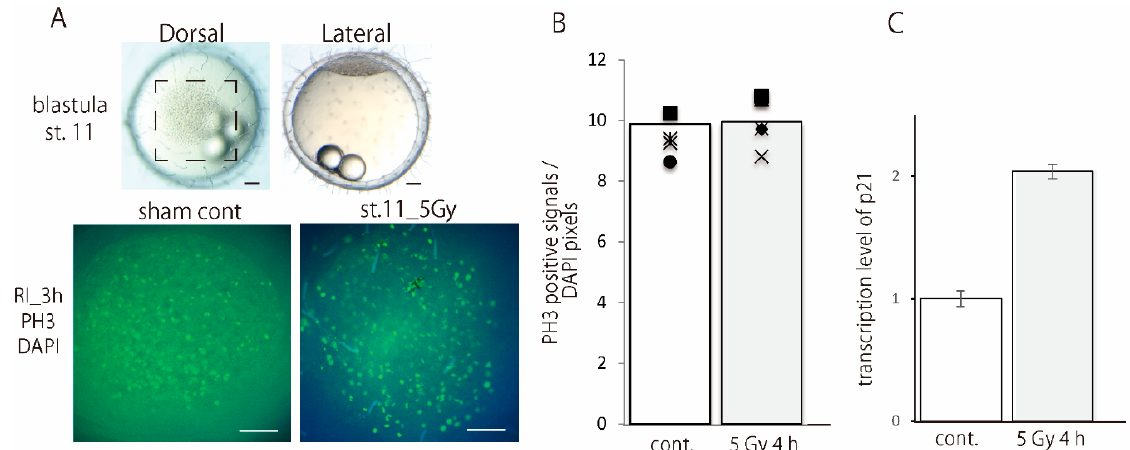
Figure 5. Irradiated blastoderm cells did not arrest cell cycle progression. Anti-phospho-histone H3 (P-H3)-positive cells were counted at 4 h after the irradiation of gamma-rays. The P-H3 positive signals in the blastoderm (squared with dotted lines in ( A )) of irradiated embryos at stage 11 (st11_5Gy) and sham control (sham cont) are shown in dorsal view in the lower row. Each data was shown with different markers in ( B ). There was not significant difference in the number of anti-P-H3 positive cells between the irradiated ( n = 5) and control embryos ( n = 4) ( B ). Quantitative real-time PCR demonstrated that p21 expression was up-regulated with twice higher in the irradiated blastula embryos at 4 h after the irradiation ( C ). Scale bars in A = 100 μ m. Error bars show S.D.